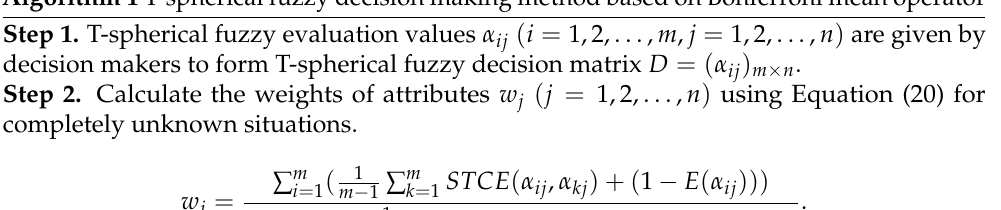
Algorithm 1 T-spherical fuzzy decision making method based on Bonferroni mean operator